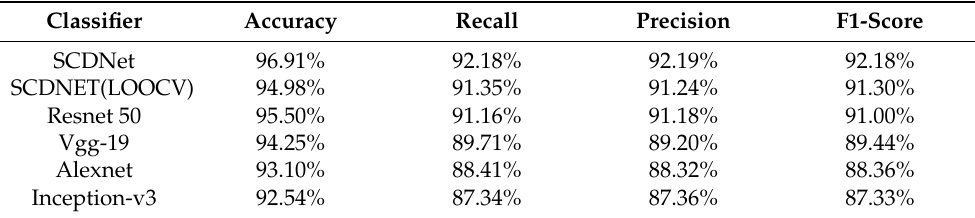
Table 5. Performance comparison of SCDNet with pre-trained